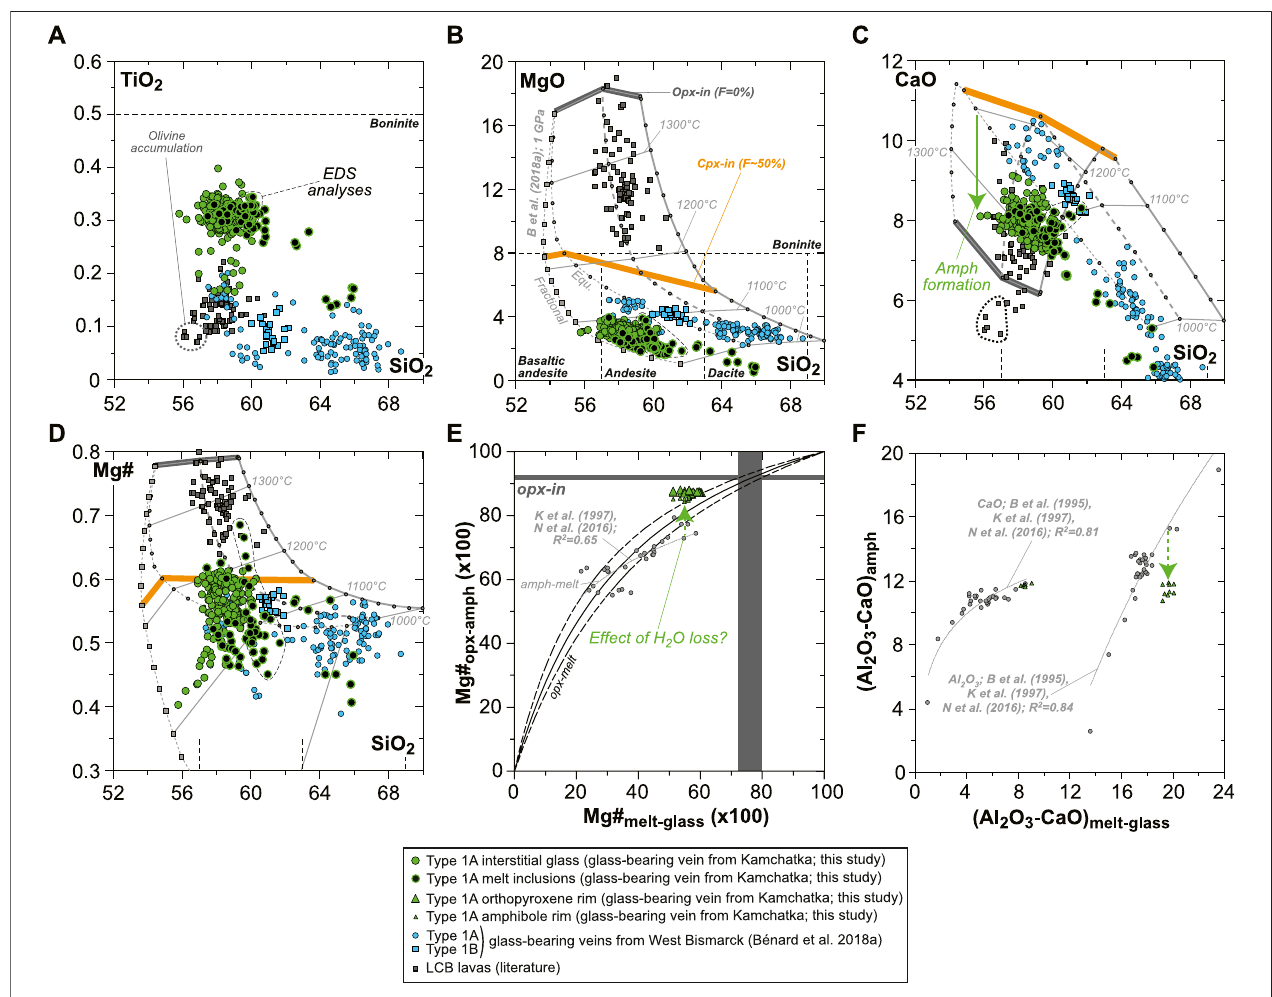
FIGURE 6 | Glass compositions and mineral – glass relationship data for the new Kamchatka vein in this study (glass and melt compositions are normalized on an anhydrous basis). (A – D) Major element compositions (in wt% for oxides) of vein MIs and interstitial glass. (E) Opx – glass and amphibole – glass Mg# relationships and (F) amphibole – glass Al 2 O 3 and CaO relationships. In (A – D) , the vein glasses are compared to isobaric models for the liquid lines of descent of harzburgite-derived melts at 1 GPa (gray lines), calculated by Bénard et al. (2018a) with pMELTS (Ghiorso et al., 2002). The starting melt compositions of those models were calculated with pMELTSforspinelharzburgitemeltingat1 GPa,1,360 ° C,andwith0.01,0.05,and0.1 wt%H 2 O(Bénardetal.,2018a).Bothliquidlinesofdescentdrivenbyequilibrium (Equ;dots)andfractional(squares)crystallizationprocessesareshownfor0.01 wt%H 2 Ointhemantlesource.Theonsetsofopx(opx-in)andcpx(cpx-in)crystallization are,respectively,indicatedwithdarkgrayandorangebars,togetherwiththecorrespondingdegreeofcrystallizationofthepyroxenite( F ,in%).Notethemoreconsistent fi ts of those models for West Bismarck glass than for Kamchatka glass (see text for details). Also shown is a compilation of LCB lavas ’ bulk-rock compositions from the literature (dark gray squares; Komatsu, 1980; Kushiro, 1982; Cameron et al., 1983; Umino, 1986; Shimizu et al., 1992; Taylor et al., 1994; Dobson et al., 1995; Pearce et al., 1999; Yajima et al., 2001; Dobson et al., 2006). The rock classi fi cation is taken from Le Bas (2000). In (E,F) , experimental amphibole – glass relationships from the literature are shown with gray dots and include data from Brenan et al. (1995), Klein et al. (1997), and Nandedkar et al. (2016).